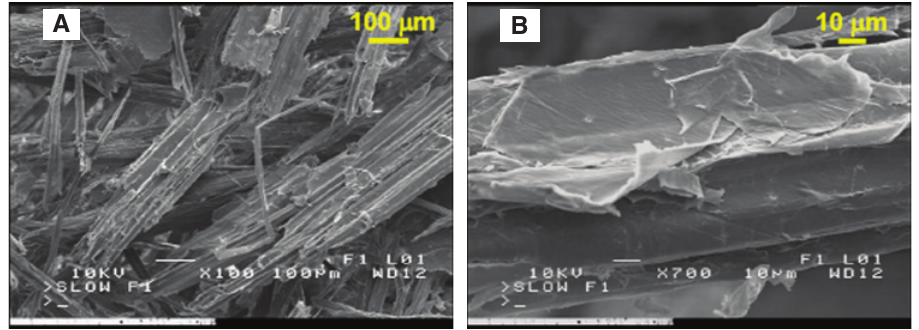
Figure 3 Triticale straw surface at different magnifications: (A) 100 times and (B) 700